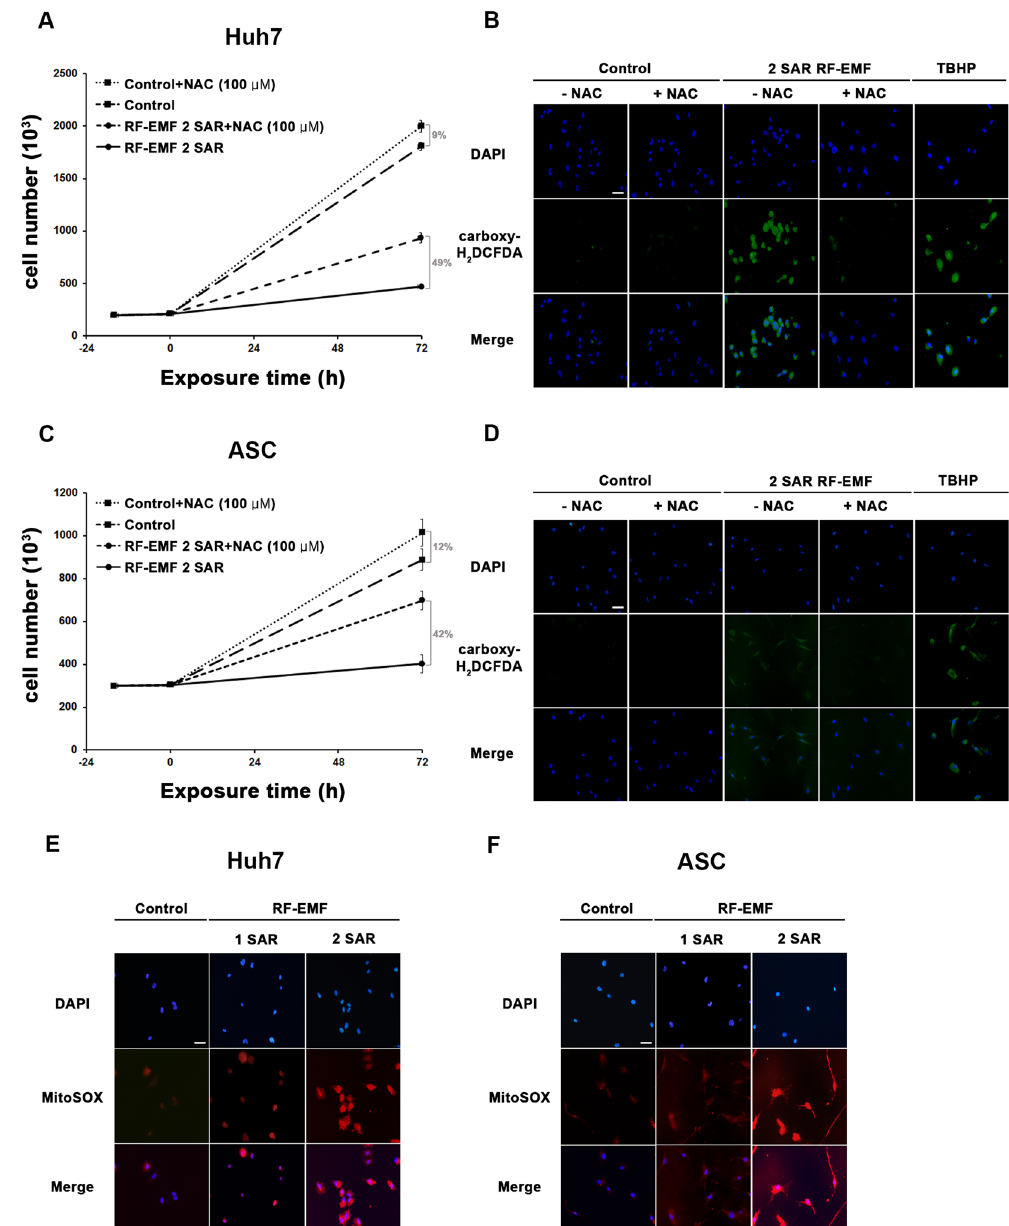
Figure 8. Continuous exposure to 1.7 GHz LTE RF-EMF decreased cell proliferation by inducing intracellular ROS in ASCs and Huh7 cells. ( A–D ) ASCs and Huh7 cells pre-treated or not with 100 μ M NAC were exposed to 1.7 GHz RF-EMF for 72 h at 2 SAR, while the sham control cells were incubated for 72 h without RF-EMF exposure. After the exposure, ( A,C ) the cells were collected and counted with a cell counter (Nexcelom Bioscience). Huh7 cells ( B ) and ASCs ( D ) were stained with carboxy-H 2 DCFDA. Cells treat with TBHP were used as a positive control for intracellular ROS generation. ( E,F ) ASCs and Huh7 cells were exposed to 1.7 GHz RF-EMF for 72 h at 1 SAR or 2 SAR, and were stained with MitoSOX. ( B,D–F ) Nuclei were stained with Hoechst 33342. Images were taken with an Axioplan2 fluorescence microscope (Zeiss) under a 200 × objective. Scale bar, 25 μ m. All experiments consisted of three independent